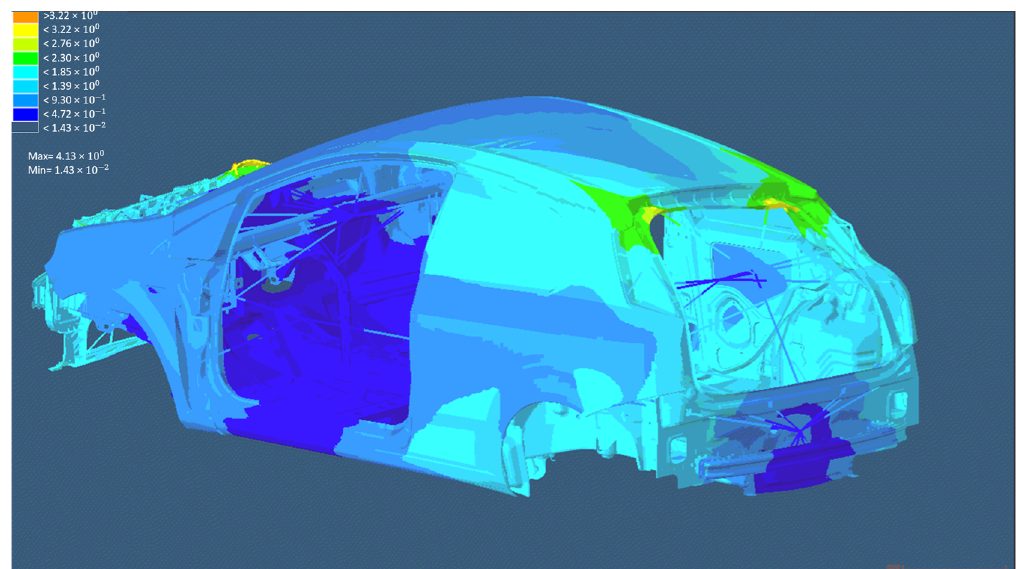
Figure 6. First torsional mode on TB model.